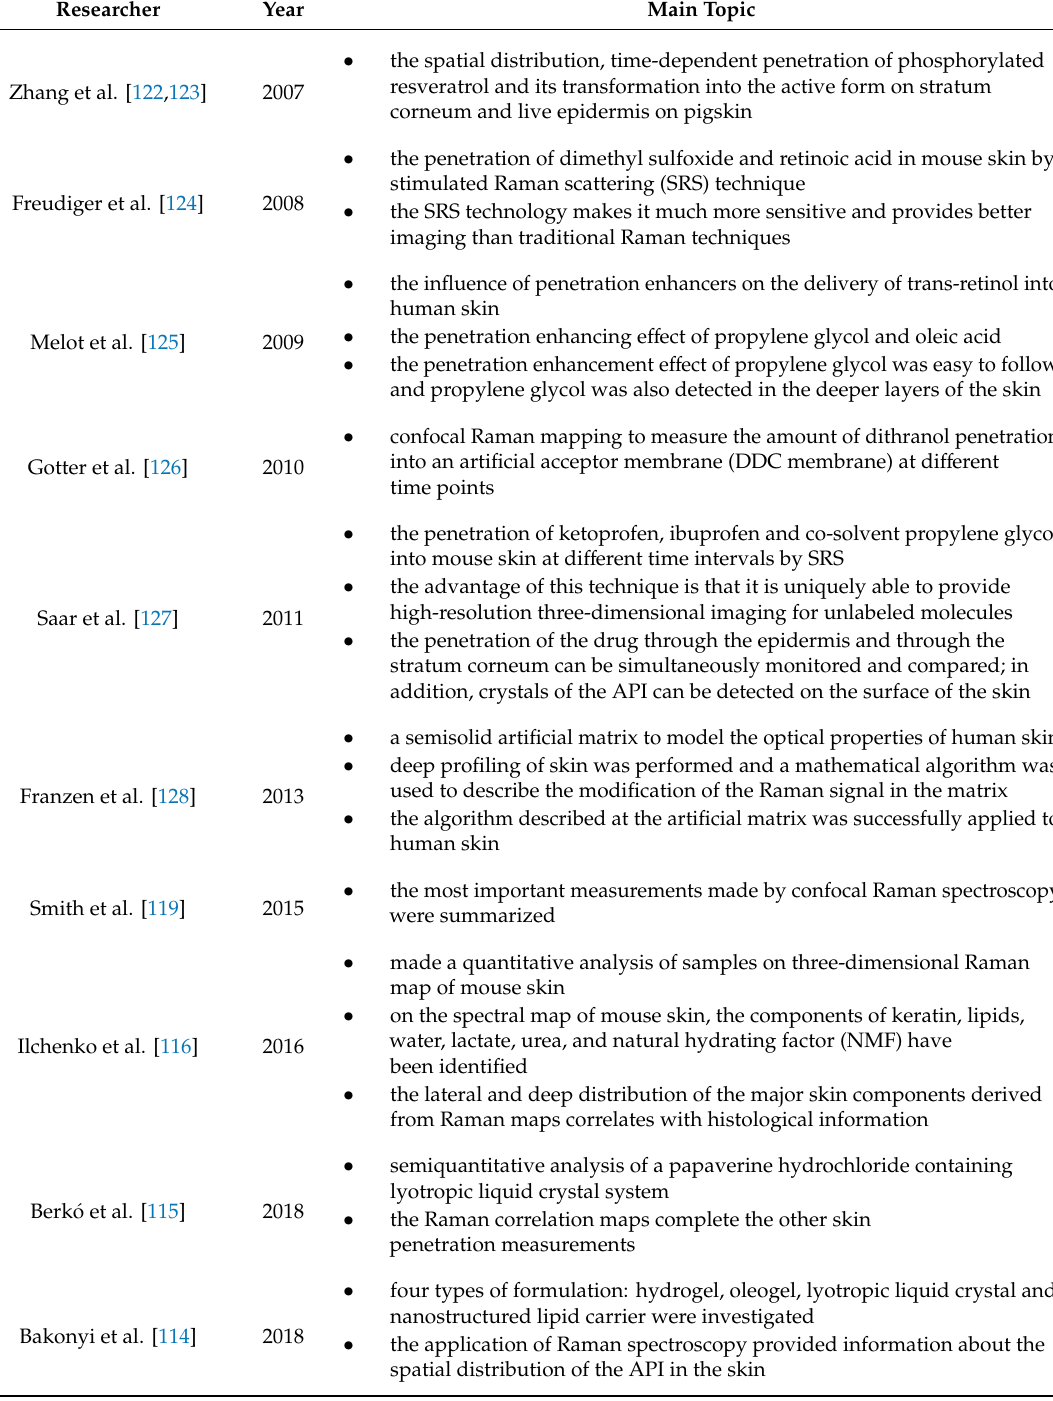
Table 6. Confocal Raman microscopic